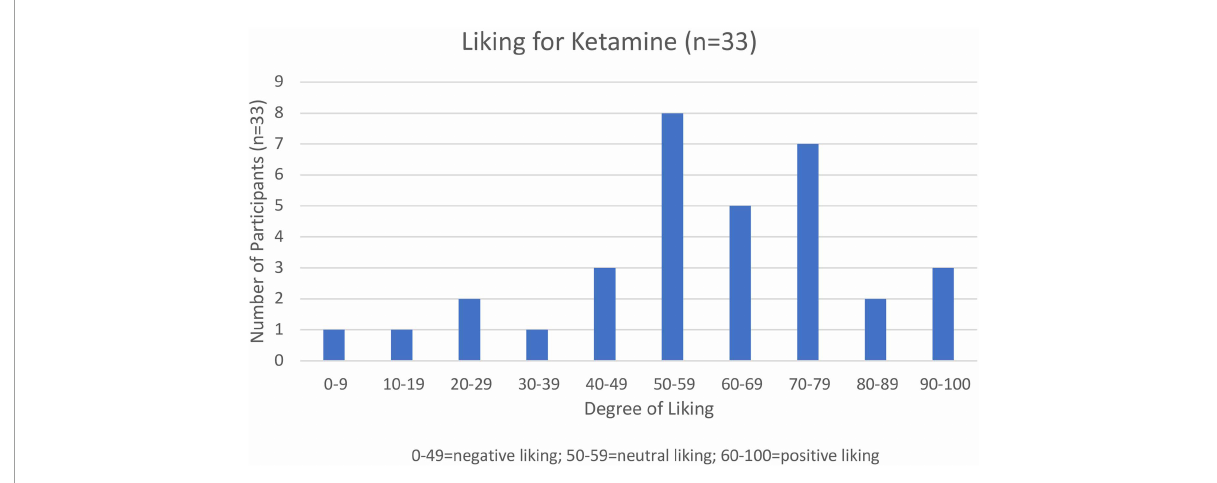
FIGURE1 Participant ratings of “drug liking” ( n = 33).